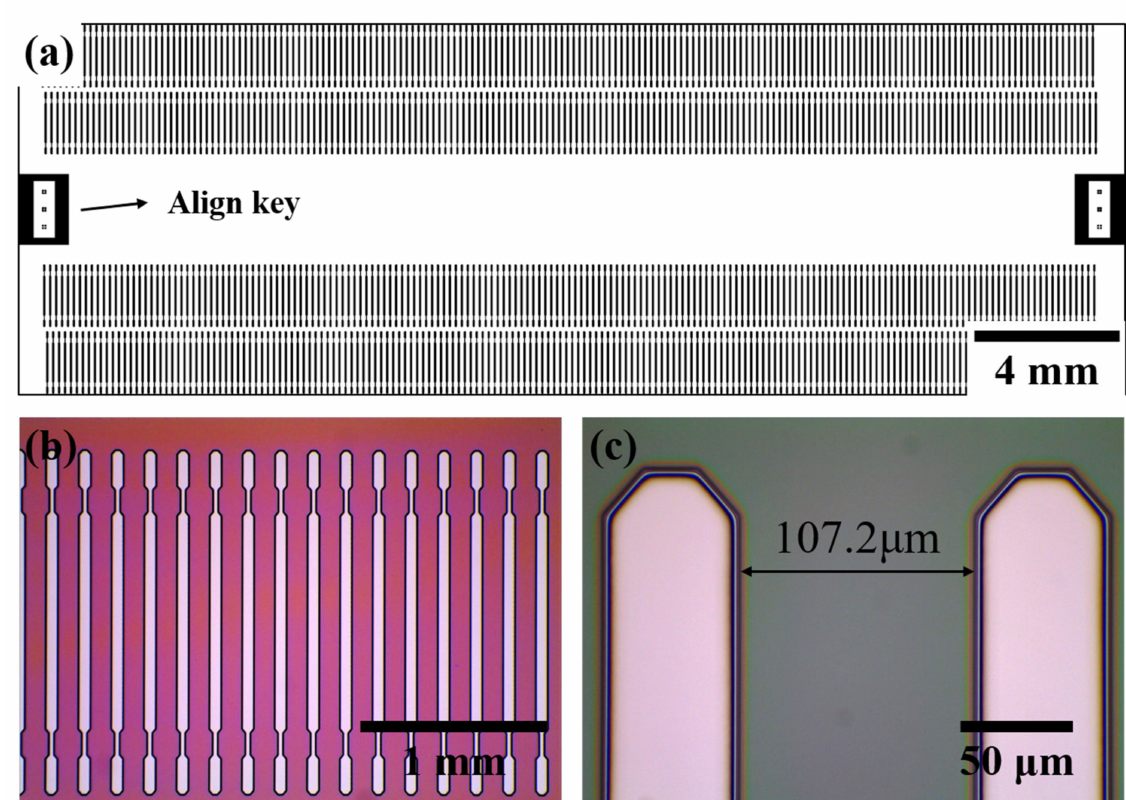
Figure 4. ( a ) Mask drawings for a 3D DVS-BCB structure pattern and ( b , c ) optical microscopic images of the fabricated 3D DVS-BCB